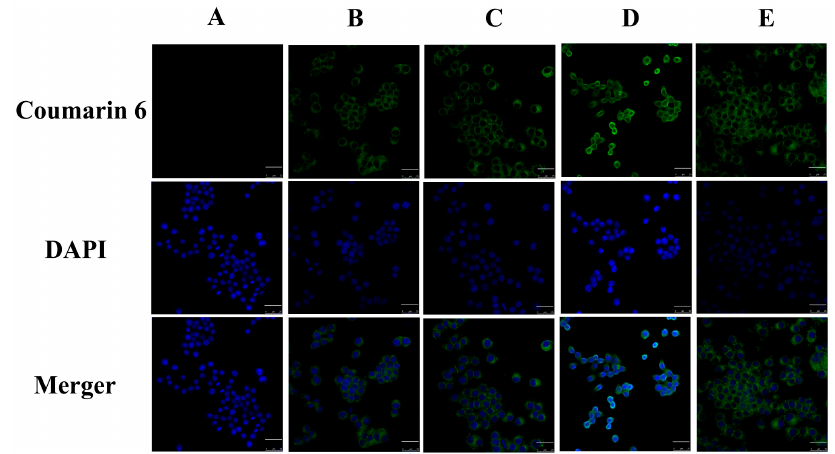
Figure 7. CLSM images. ( A ) negative control group (blank culture medium without NLCs); ( B ) 0% PS containing C6-mNLCs; ( C ) 4% PS containing C6-mNLCs; ( D ) 8% PS containing C6-mNLCs; ( E ) 12% PS containing C6-mNLCs. The cellular uptake of C6-mNLCs was increased with an increasing amount of PS in the nanoparticles, up to 8% PS. Also, the uptake was decreased when PS concentrations reached 12%. Scale bar is 25 μ m.